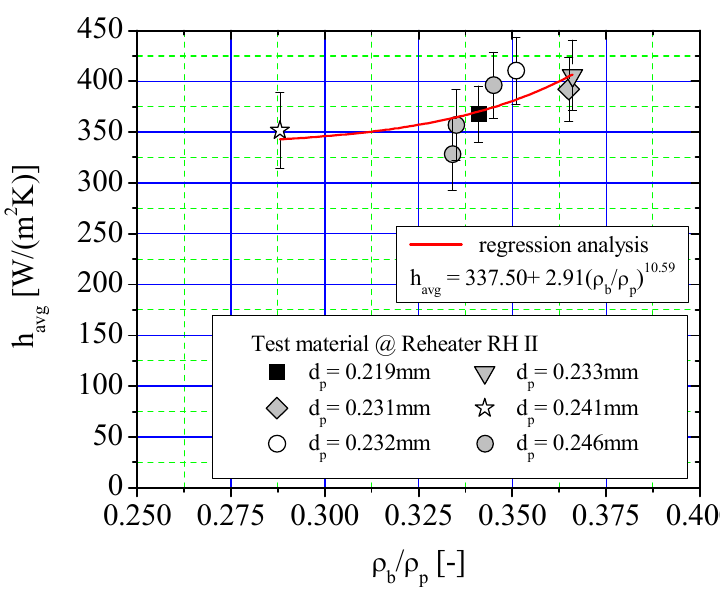
Figure 8. Average bed-to-tube heat transfer coefficient as a function of normalized suspension density.